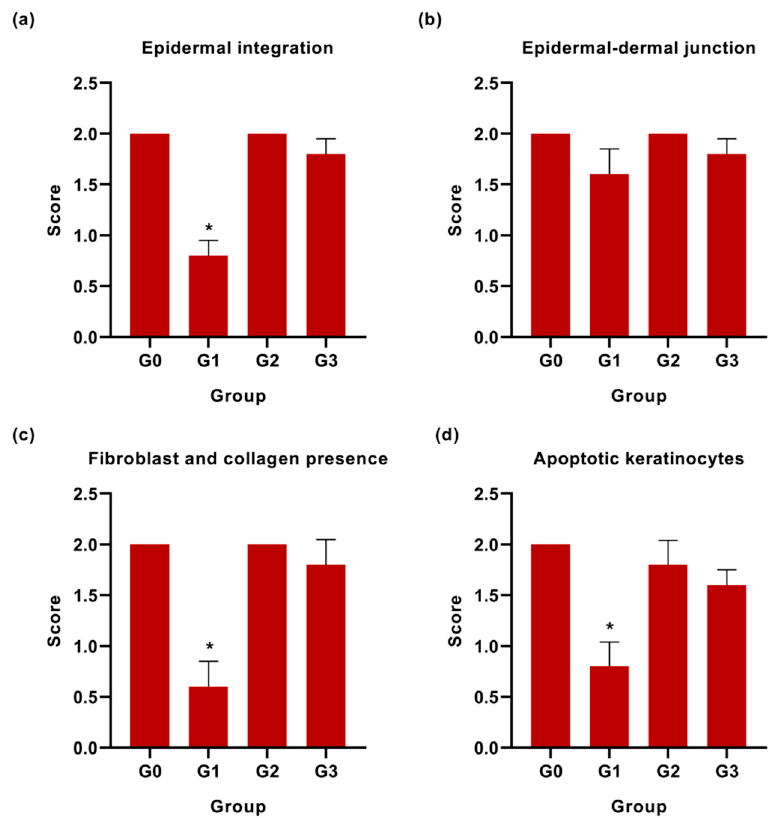
Figure 8. Graphical presentation (mean ± SD) of the histological scoring of ( a ) epidermal integration, ( b ) epidermal-dermal junction, ( c ) fibroblast and collagen presence, and ( d ) apoptotic keratinocytes in skin tissue among four experimental groups. The G0, G1, G2, and G3 represent Group 0 (normal skin tissue), Group 1 (Control), Group 2 (Palmitoyl-GDPH treated skin tissue), and Group 3 (tetracycline treated skin tissue), respectively. The asterisks (*) represent significant difference (* p < 0.05) from positive control (normal skin group; Group 0).